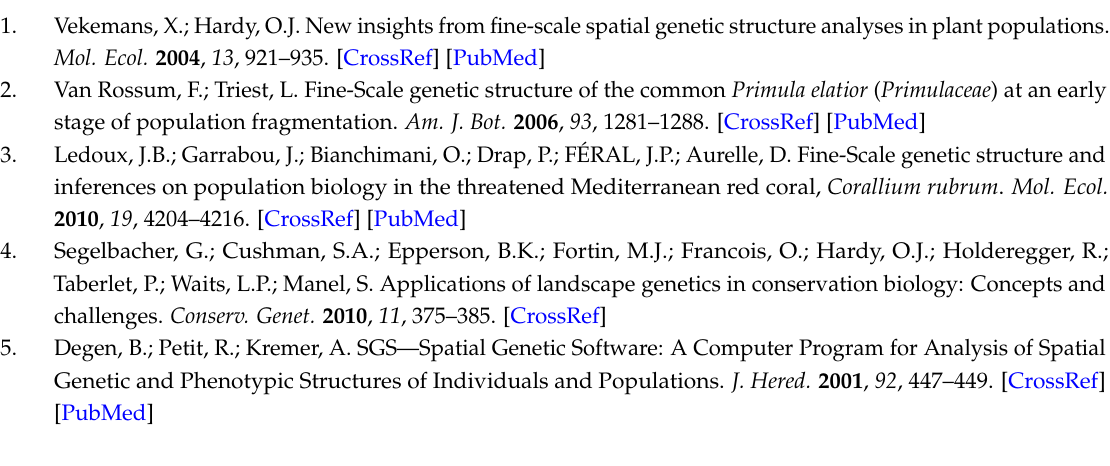
Figure S1: Results of Principal Coordinates Analysis ( PCoA ) of the individual Pinus engelmannii (a) and Pinus leiophylla trees (b). The first two coordinates together explained 11.01% and 11.48%, respectively, of the variation in AFLP. For definitions of the stand codes, see in caption of Figure 5 in the paper, Table S1: Analysis of fine-scale with GenAlex and SPAGeDi in seven seed stands of Pinus engelmannii and nine seed stands of P. leiophilla by considering a distance class width of 150 m, 999 bootstraps or 999 permutations and a 99% confidence interval. The genetic distance of Huff (GD) was calculated using GenAlEx 6.501. The pairwise kinship coefficient (F ij ) was calculated using SPAGeDi 1.4, Table S2: Analysis of spatial genetic structure among seven Pinus engelmannii seed stands by considering a distance class width of 160 m in the northern stands and 24 km in the southern stands, 999 bootstraps and permutations and a 99% confidence interval. The genetic distance of Huff (GD) was calculated using GenAlEx 6.501, and the pairwise kinship coefficient (F ij ) was calculated using SPAGeDi 1.4, Table S3: Analysis of large-scale spatial genetic structure in nine seed stands of Pinus leiophylla by considering a distance class width of 8 km in the stands, 999 bootstraps or 999 permutations and a 99% confidence interval. The genetic distance of Huff (GD) was calculated using GenAlEx 6.501, and the pairwise kinship coefficient (F ij ) was calculated using SPAGeDi